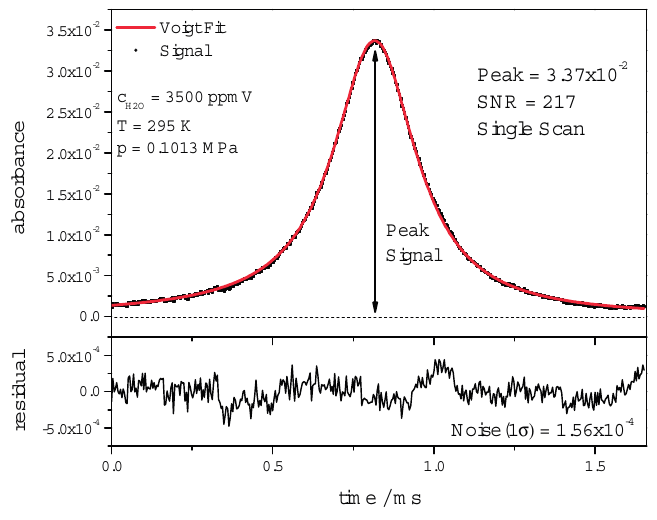
Figure 5. Single scan (simultaneously to WMS acquired) dTDLAS line profile at 3500 ppmV. The H 2 O concentration is obtained using a nonlinear Levenberg-Marquardt multi-line Voigt fit algorithm. The residuum is shown below with an absorbance noise of 1.56 × 10 − 4 resulting in a SNR of